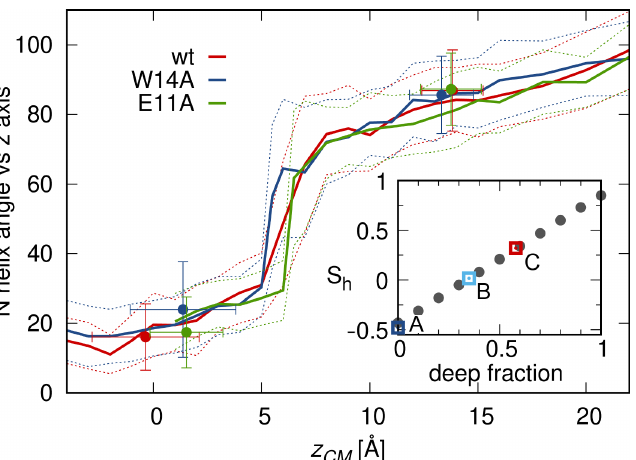
Figure 4. N-helix angle with respect to membrane normal in degrees as a function of insertion depth. Lines represent data from umbrella sampling simulations for restrained hairpin conformations, while points are data from unrestrained simulations. Error bars correspond to one standard deviation. Inset: The estimated N-helix order parameter as a function of deep configurations fraction. Squares are the experimental data for S h : (A) W14A [14]; (B) wt HAfp20 [53]; and (C) wt HAfp23